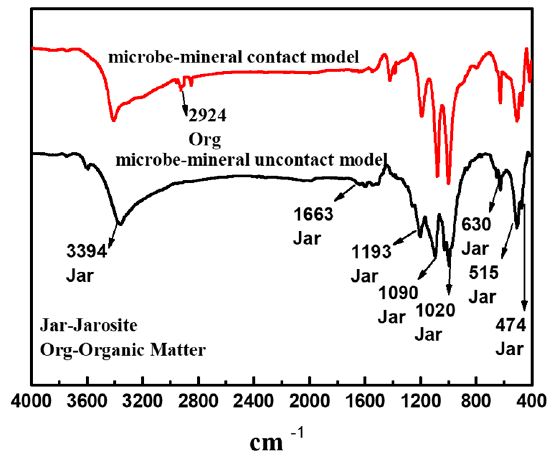
Figure 9. Fourier-transform infrared (FTIR) spectra of leaching residue.